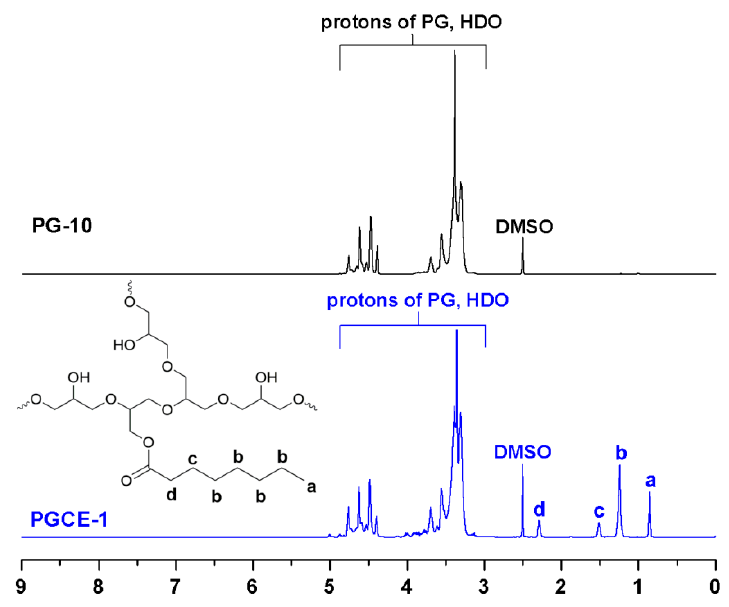
Figure 2. The proton nuclear magnetic resonance ( 1 H NMR) spectra of PG-10 and PGCE-1 in dimethyl sulfoxide-d 6 .